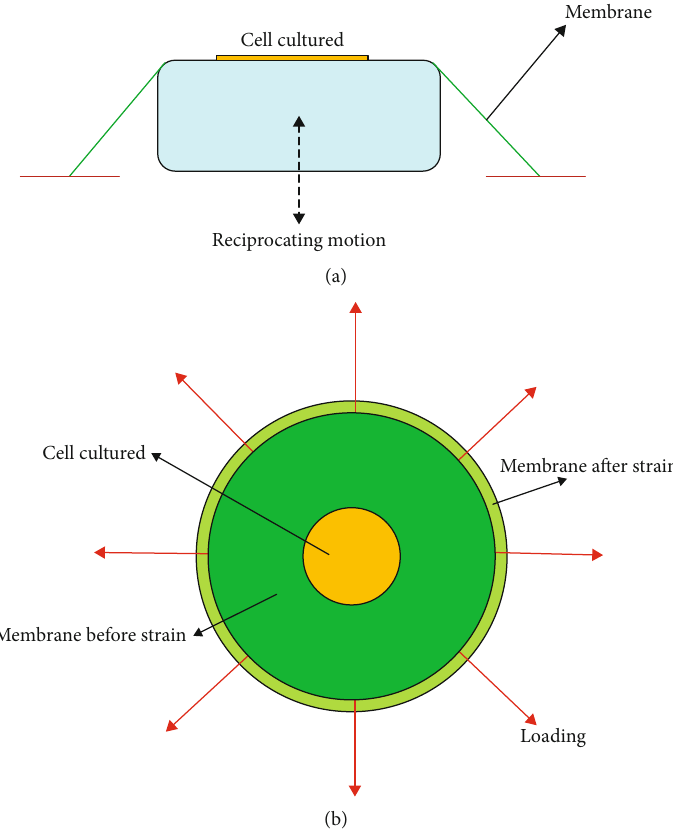
Figure 2: The schematic of an equiaxial cyclic bioreactor: (a) front view; (b) top view. Table 1: Di ff erent immunization strategies using MSCs, DCs, and proteins in BALB/c mice.